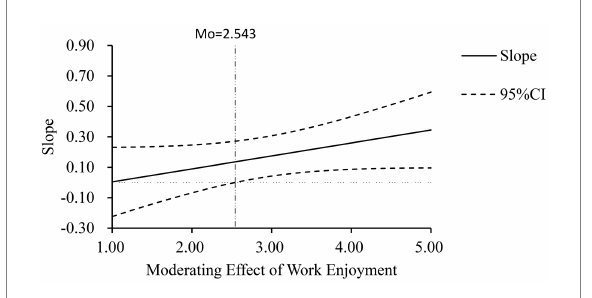
FIGURE 2 The moderating effect of work enjoyment (Johnson–Neyman